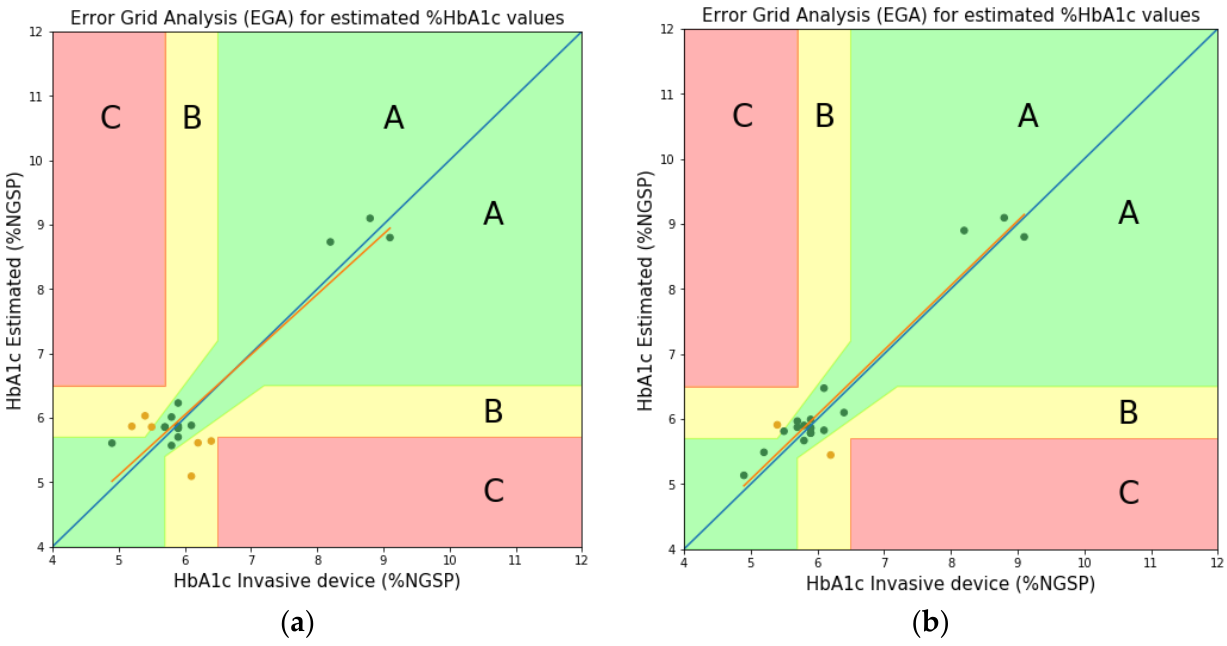
Figure 10. HbA1c Clarke’s error grid analysis (EGA) based on theoretically obtained molar absorption coefficients [15]. ( a ) Blood vessel model; ( b ) Whole finger model.